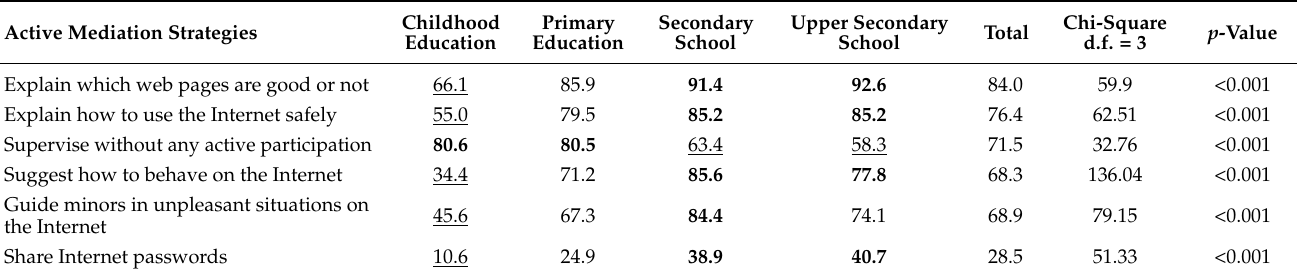
Table 3. Active mediation measures by educational stage.